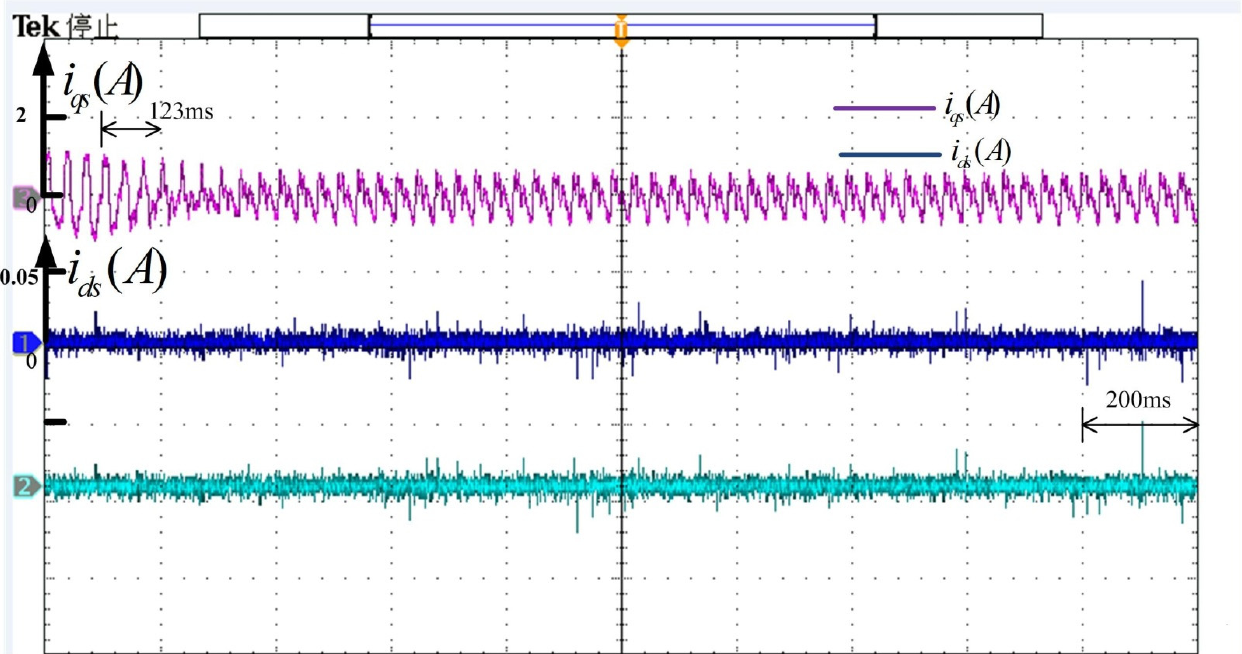
Figure 5. The validation results of the adaptive PI + RBFNN-PID control for the abrupt load torque change of system parameters under inductance parameters L d = 1.2ˆ L d , L q = 0.8ˆ L q . The top plot displays the q -axis stator current ( i qs ), and the bottom plot displays the d -axis stator current ( i ds ).